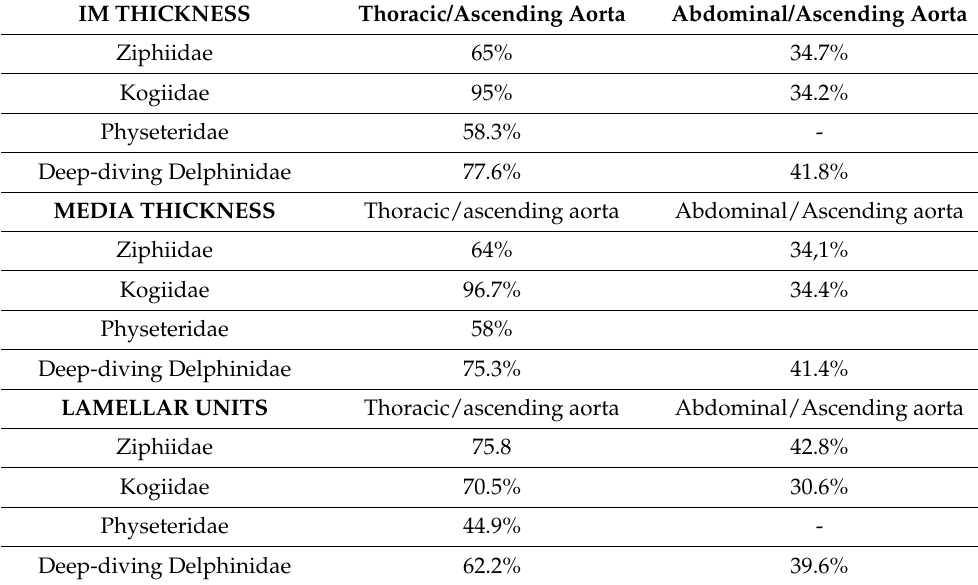
Table 4. Relationship of the IM and tunica media thickness and the number of lamellar units between the aortic location by families.